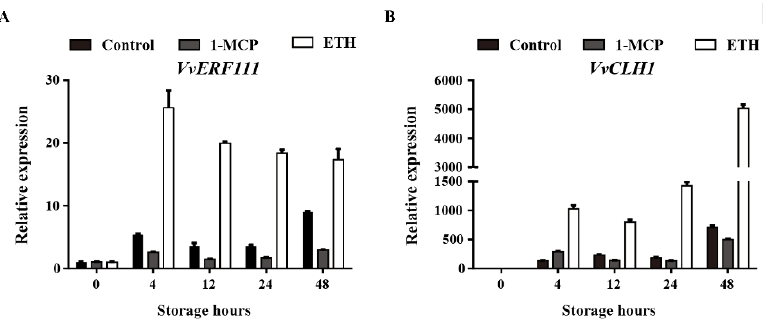
Figure 2. Expression of VvERF111 ( A ) and VvCLH1 ( B ) during rachis browning of grape and their responses to ethylene and 1-MCP treatments. Data represented mean ± SE from three independent biological replicates.